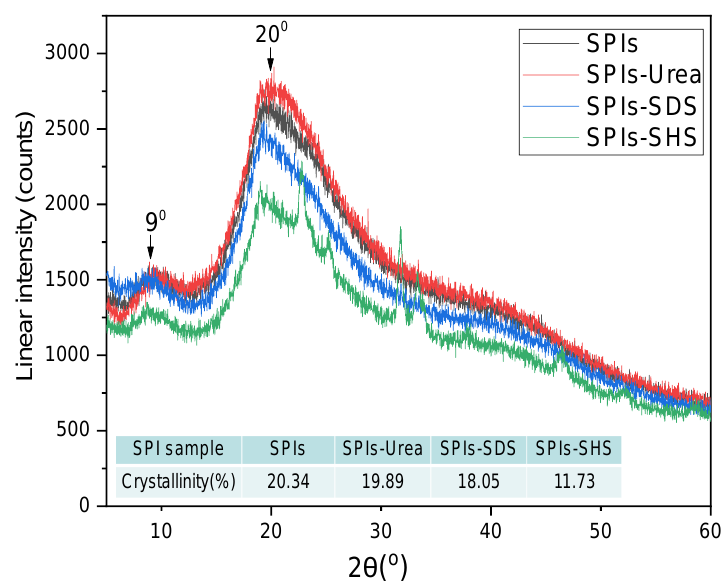
Figure 4. X-ray di ff raction pattern and the crystallinity of the cured adhesive samples. Figure 4. X-ray diffraction pattern and the crystallinity of the cured adhesive samples.